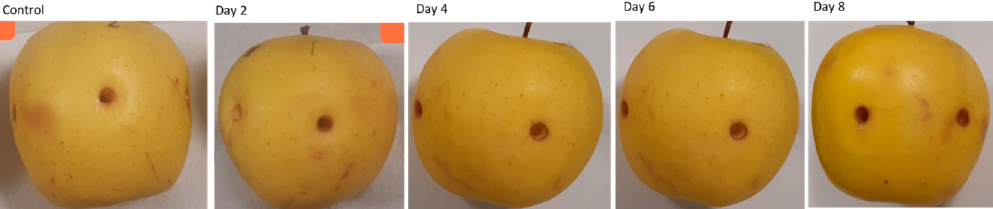
Figure 6. In vivo inhibition of S. liquefaciens on apple fruits using OEO. Exactly 3mL of bacterial suspension of S. liquefaciens MDK33 from an 18-hour-old nutrient agar culture (10 6 CFU/mL) was mixed with the MIC value of OEO (MIC 0.23 mg/mL) and incubated at 30 °C for 30 min. The wounds were artificially infected with 100 μ L of bacterial solution (10 6 CFU/mL). Treatment with sterile dis- tilled water represented a negative control. Infected apples were monitored by measuring two per- pendicular diameters of the rotten areas (average in mm: 0, 1 ± 0.1, 1 ± 0.2, 1 ± 0.3 and 1 ± 0.3) 2, 4, 6 and 8 days after infection, respectively.